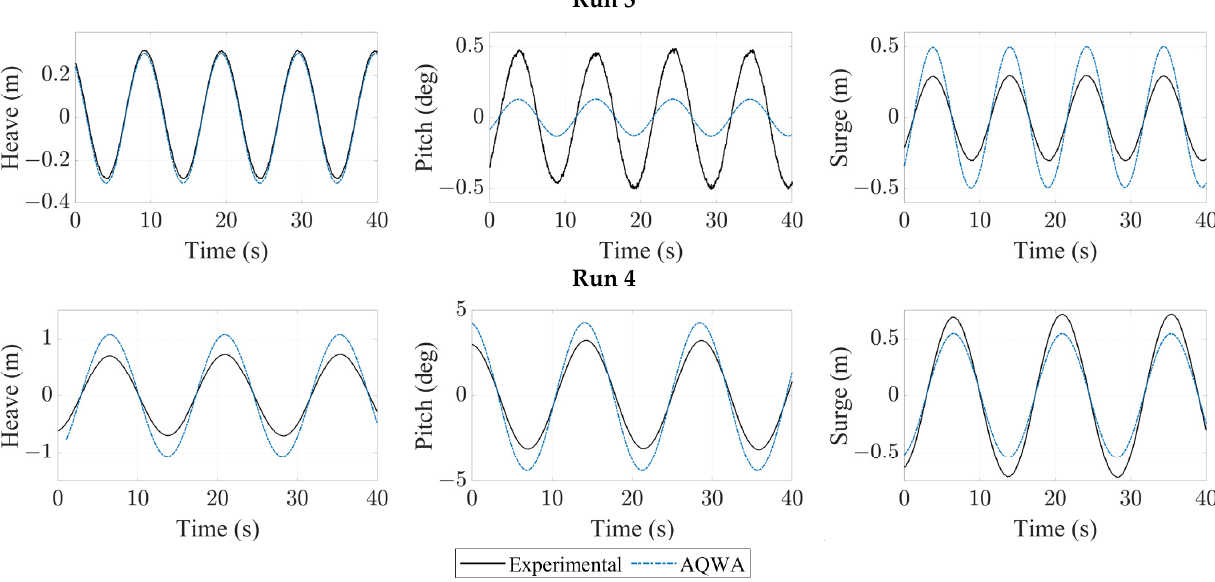
Figure 8. Experimental and numerical results for regular waves ( H = 1.404 m for all cases; T = 7.2–14.4 s).